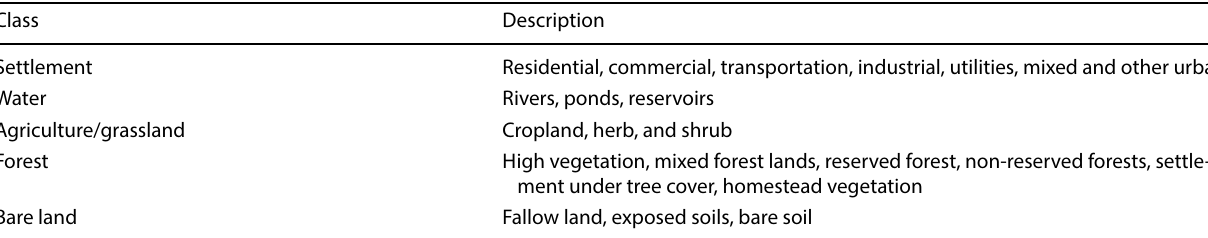
Table 2 Land cover classification